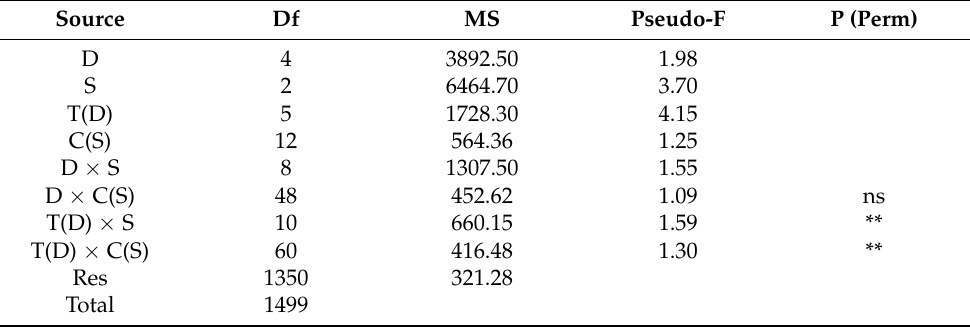
Table 4. Results of multivariate permutational analyses (PERMANOVA) on gut contents of polyps of different colonies of three species investigated across several temporal scales (Day, Time).